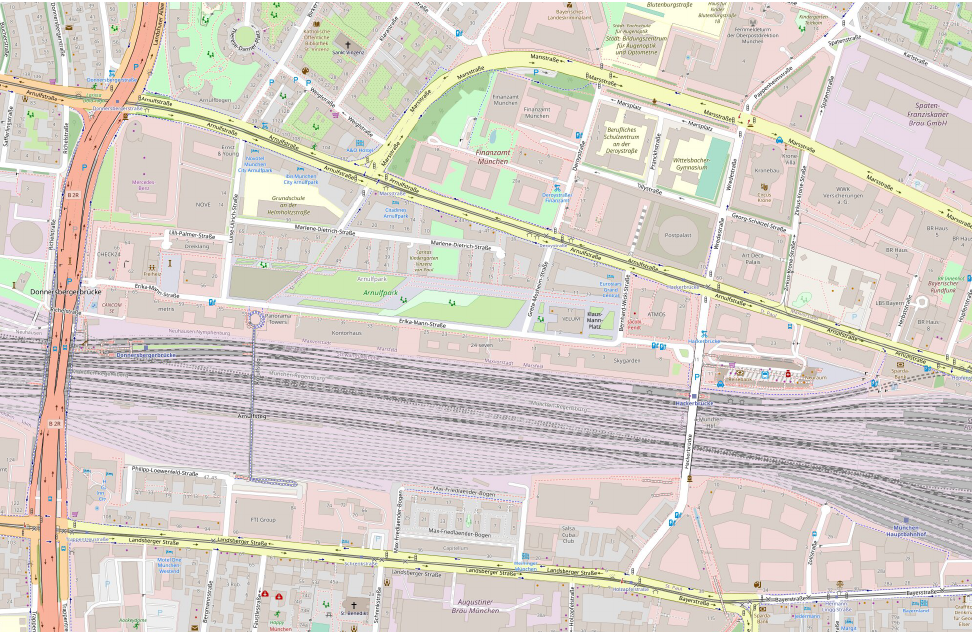
Figure 10. Visualization of the Munich dataset via OpenStreetMap, covering the indexed area [48.14, 48.145] north latitude and [11.54, 11.543] east longitude from www.openstreetmap.org (accessed on 19 December 2021) with a scale factor of 16. The map is oriented north-up. © OpenStreetMap contributors.